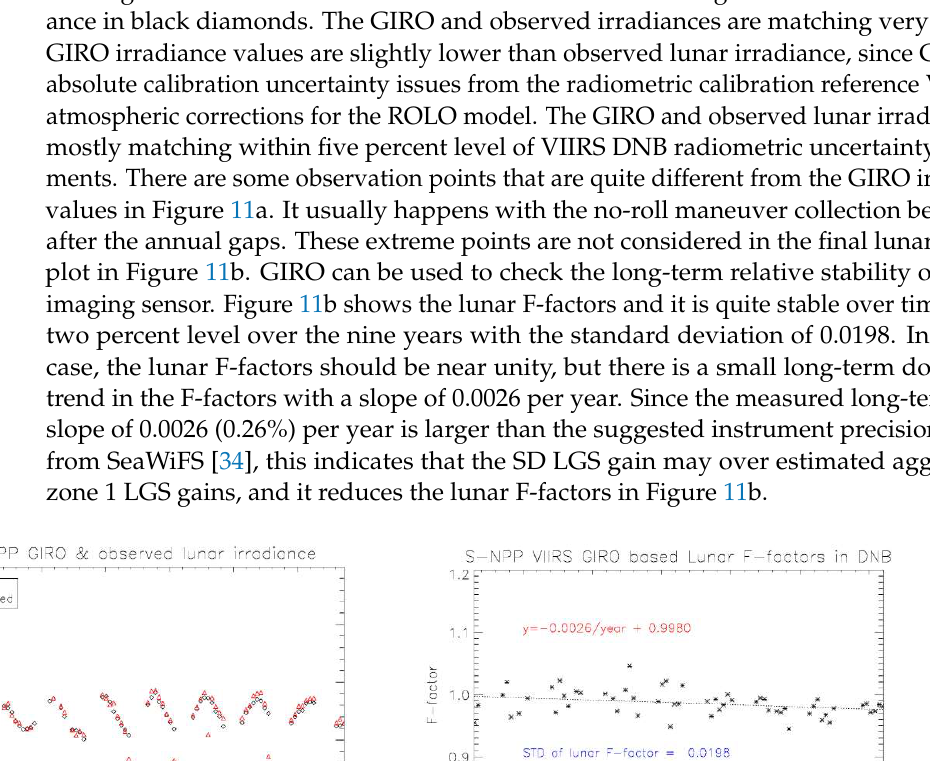
Figure 11a shows observed lunar irradiance in red triangles and GIRO model irradi-